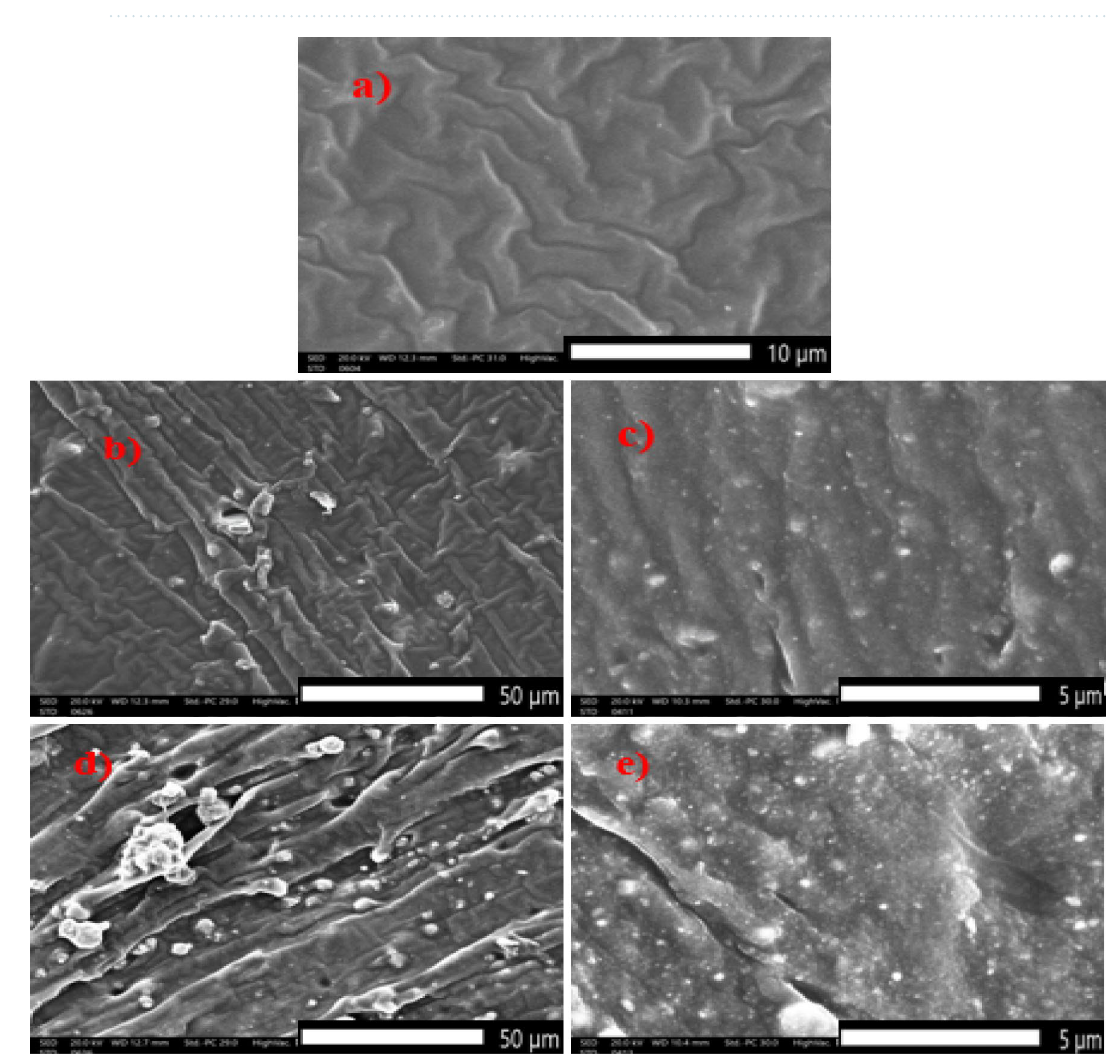
Figure 3. SEM image of ( a ) free silicon rubber, ( b ) 20% micro tin oxide/silicon rubber, ( c ) 20% nano tin oxide/ silicon rubber, ( d ) 50% micro tin oxide/silicon rubber, and ( e ) 50% nano tin oxide/silicon